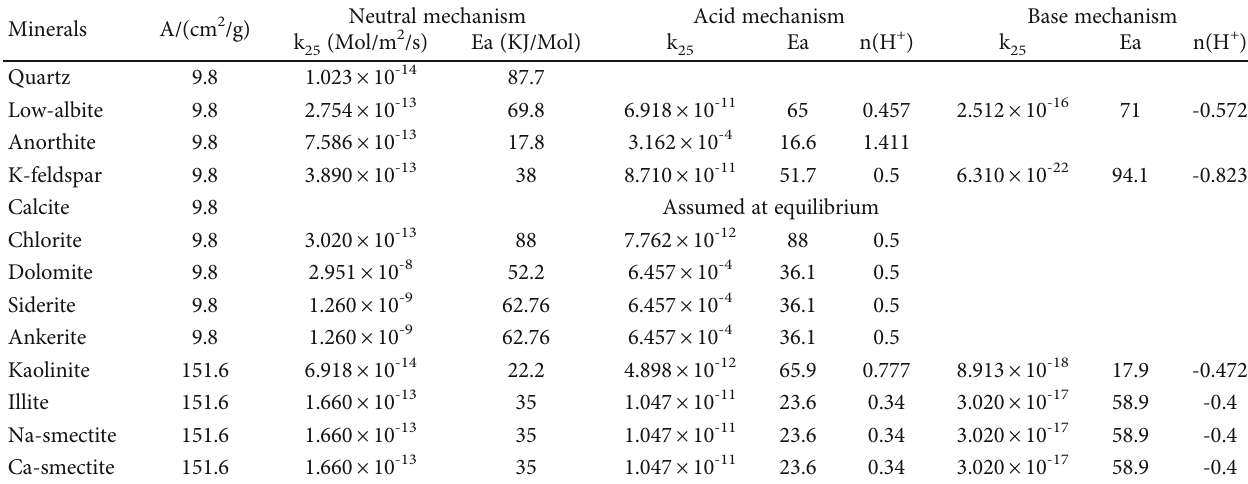
Table 3: Parameters for calculating kinetic rate constants of